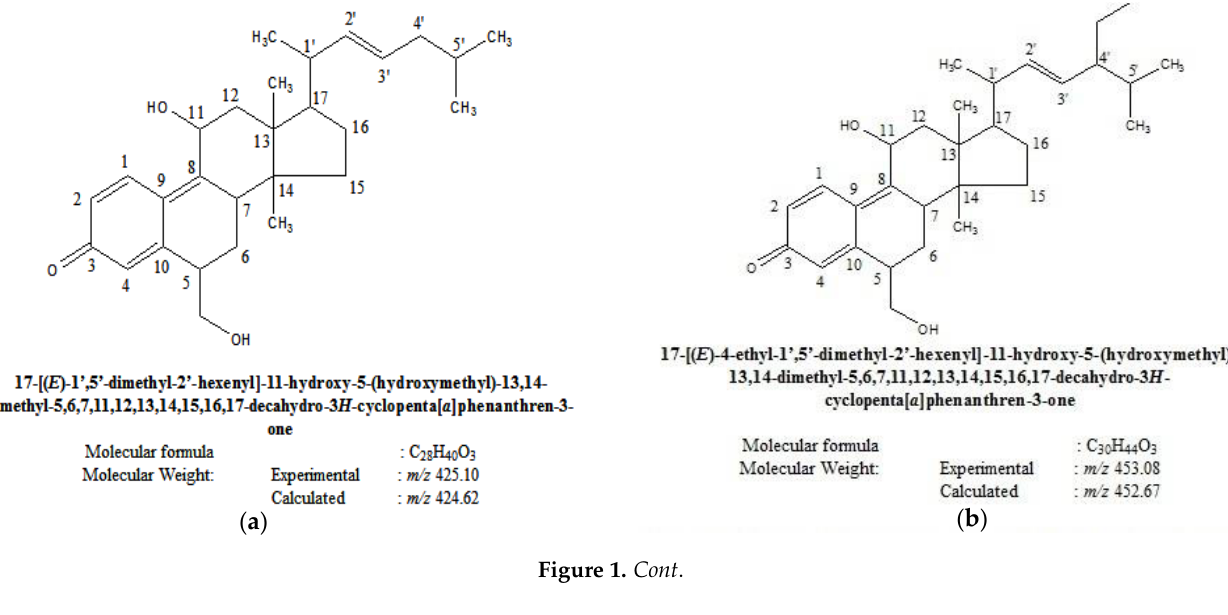
Figure 1. Structures of the novel compounds ( a ) 2879/CHE/2012(cpd-1); ( b ) 2880/CHE/2012(cpd-2); ( c ) 2881/CHE/2012(cpd- 3). Figure 2. Effect of novel triterpenoids on plasma glucose in STZ-induced diabetic rats compared with the effect of insulin. Each bar represents Mean ± SEM of 6 animals. Significance at p < 0.05; *, compared with control; **, compared with diabetic control.